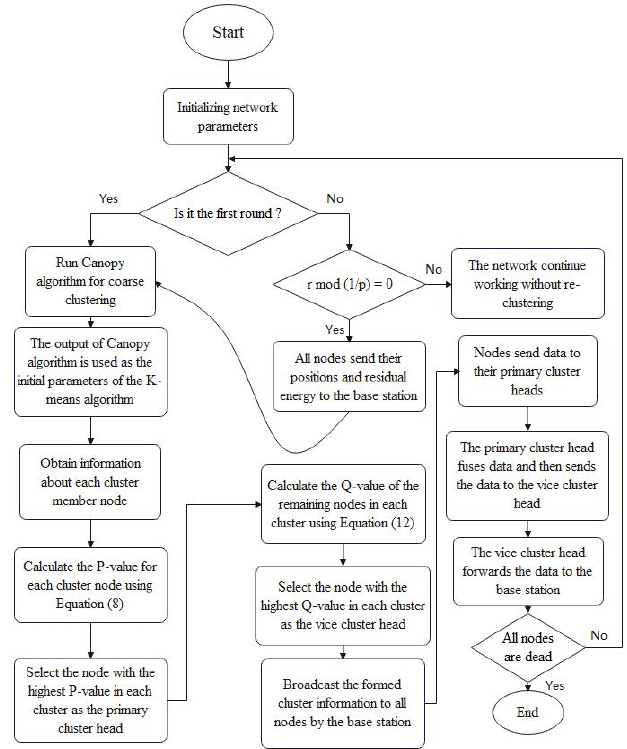
Figure 2. The workflow of proposed protocol.